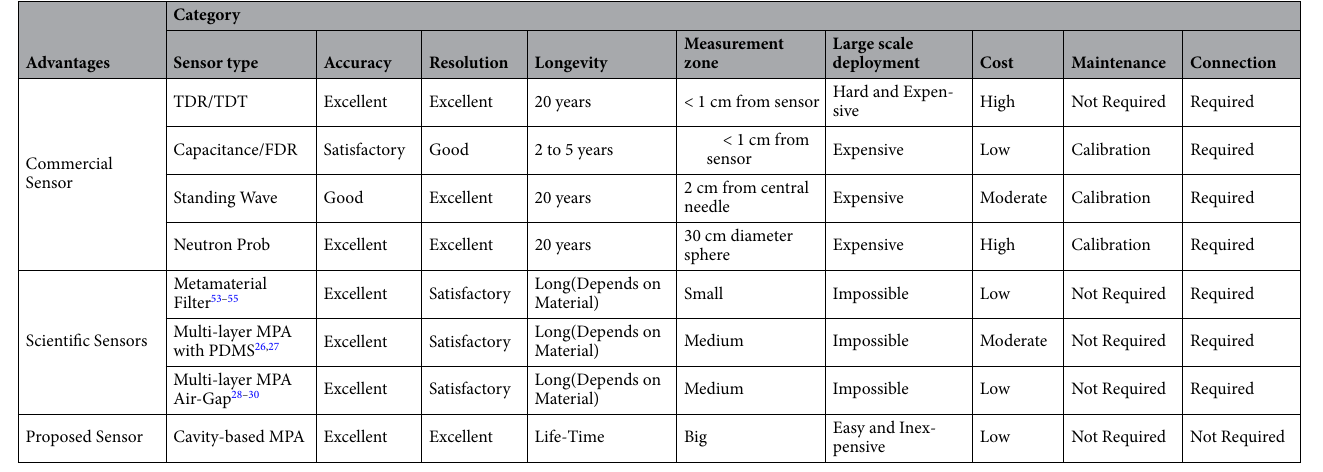
Table 3. Comparing different types of soil moisture sensor based on various